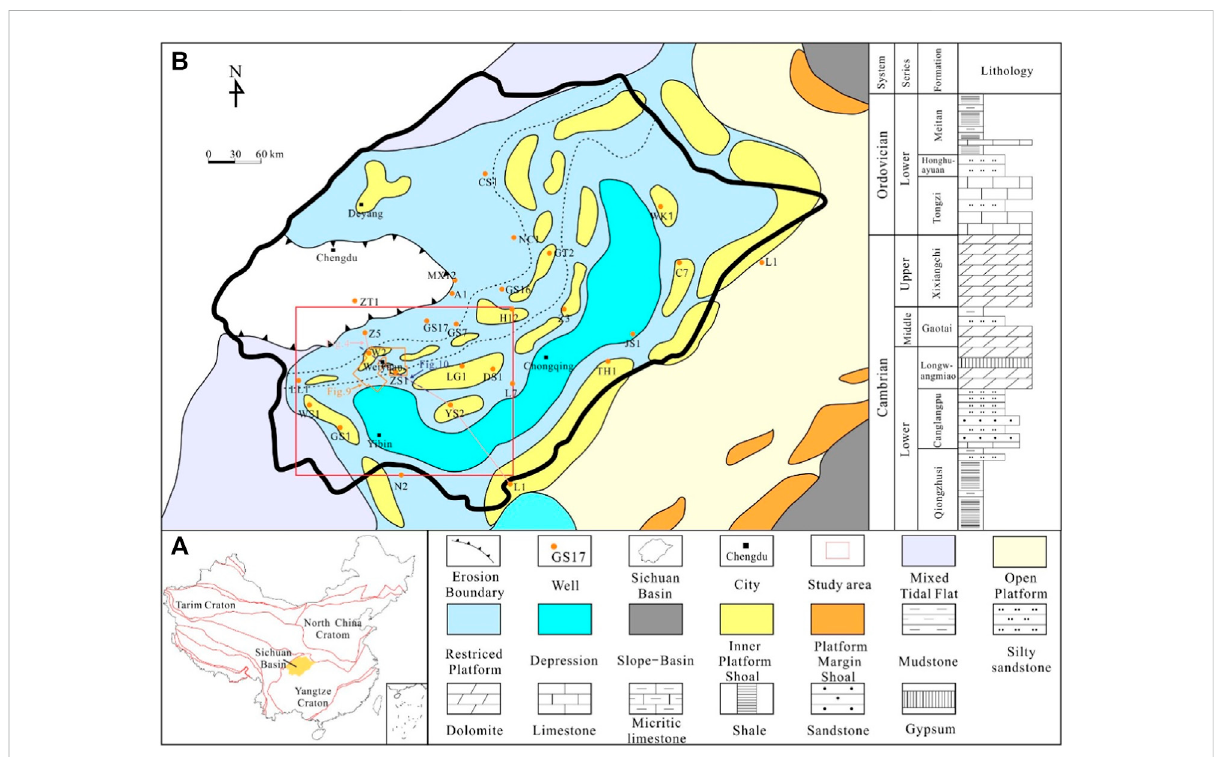
FIGURE 1 Comprehensive geological map of the study area. (A) Sketch map of tectonic units in China and the location of study area [modi fi ed form Luo et al.(2016)]; and (B) Lithofacies and paleogeography map of the Cambrian Xixiangchi period in Sichuan Basin [modi fi ed form Gu et